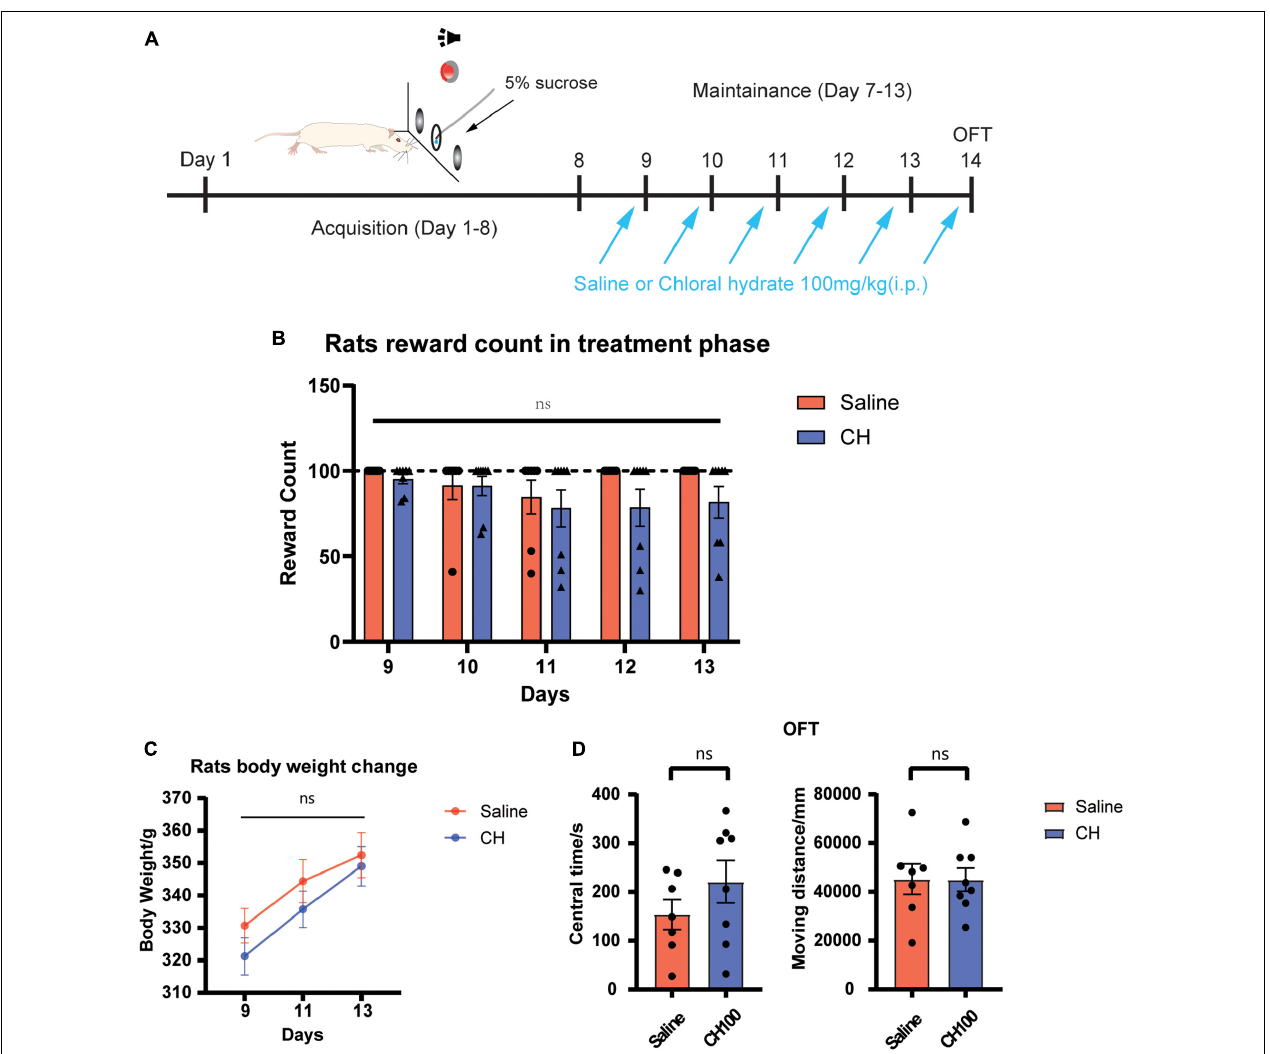
FIGURE 5 | Chloral hydrate had no obvious side effects ( N = 7 in Saline group and N = 8 in CH100 groups). (A) Timeline for sucrose self-administration. (B) Chloral hydrate did not affect sucrose self-administration behavior. (C) Chloral hydrate had no significant effect on the weight in rats. (D) Chloral hydrate did not change locomotor activity and anxiety